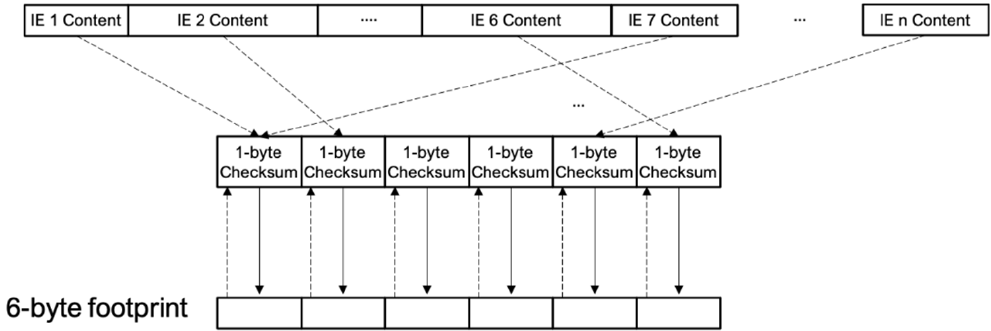
Figure 6. Procedure for obtaining the 6-byte footprint.